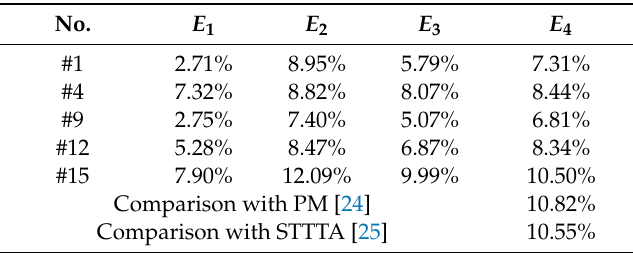
Table 6. Detection error rates of CSM compared with the reference method by training and testing times with five ten times with five samples.